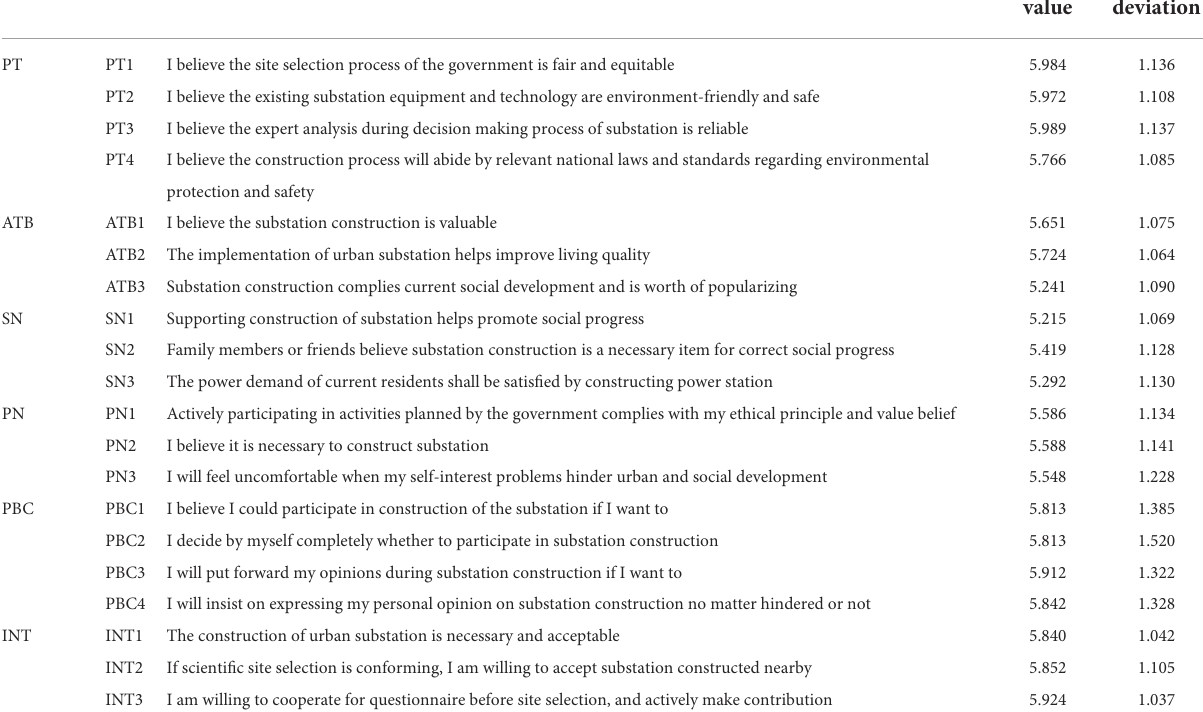
TABLE 3 Scale design and descriptive